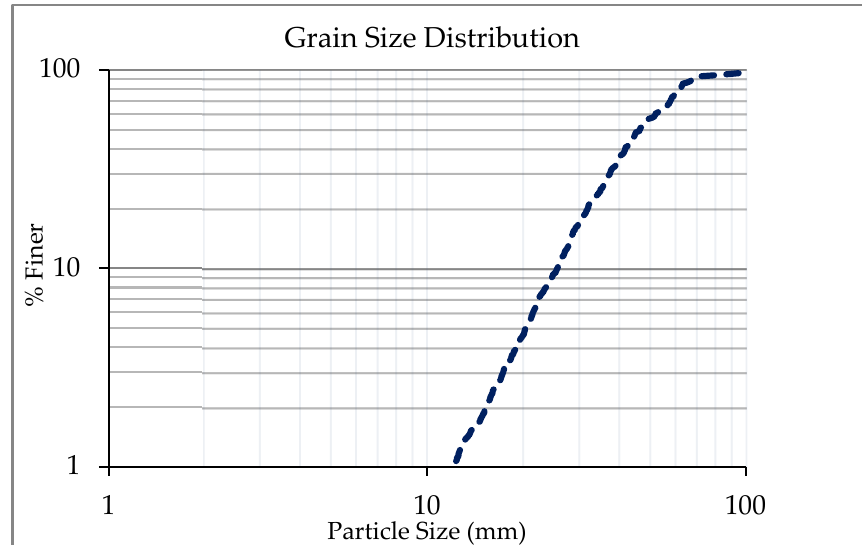
Figure 4. Grain size distribution in the selected reach (Wolman method).